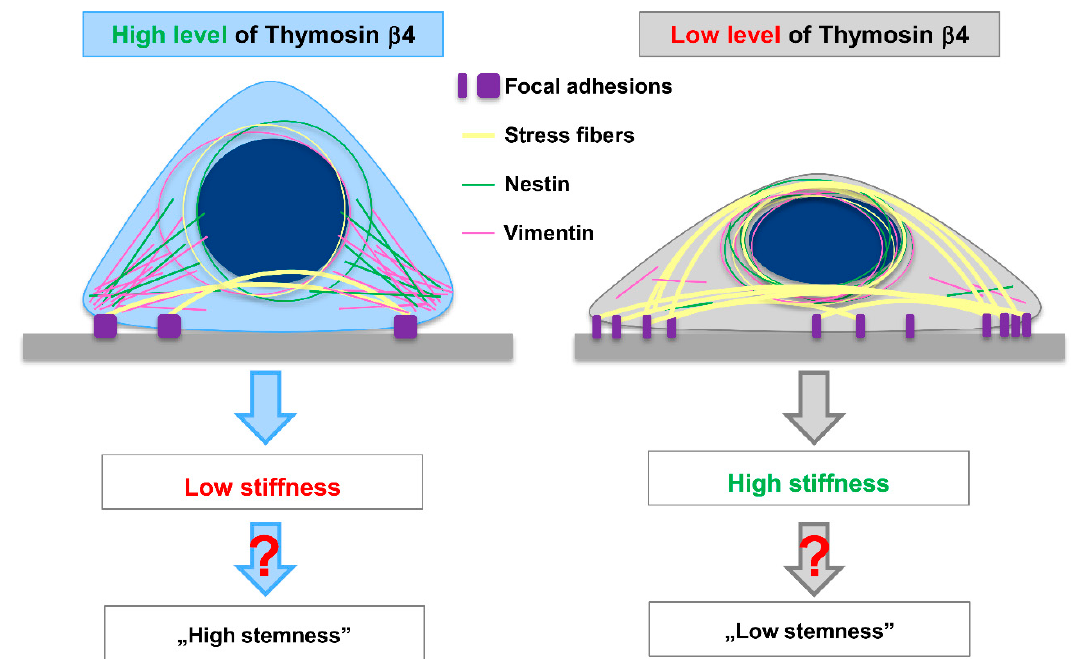
Figure 9. A summary of obtained results. Accordingly to the results obtained by us for the A375 cells with decreased TMSB4X expression, lowering T β 4 level leads to reorganization of focal adhesion [8]. The cells form more focal adhesion (FA) sites but of smaller size. That leads to more pronounced stress fibers and Vimentin and Nestin’s relocalization towards the perinuclear area, where “rings” of these intermediate filaments (IF) proteins are observed around the cell nucleus. Finally, the cells are more spread on the substratum [8] and become stiffer. Changes in the cells’ biomechanical properties with lowered TMSB4X expression influence stemness features only in a part of cell clones.